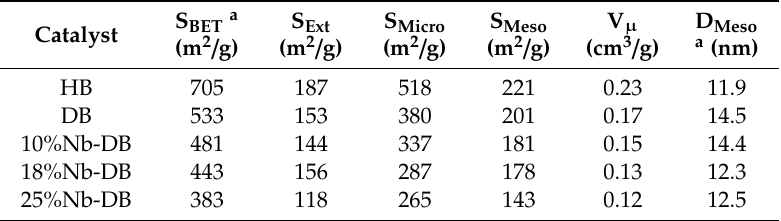
Table 3. Textural properties of the catalysts.